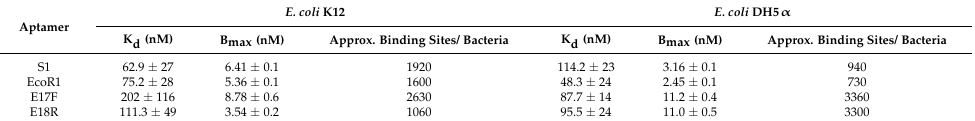
Figure 3. Binding isotherms for four DNA based aptamers with ( a ) E. coli K12 and ( b ) E. coli DH5 α . Table 3. Aptamer binding capacity (B max ) with nonspecific E. coli . Data represent Mean ± SD of 3 independent experiments.